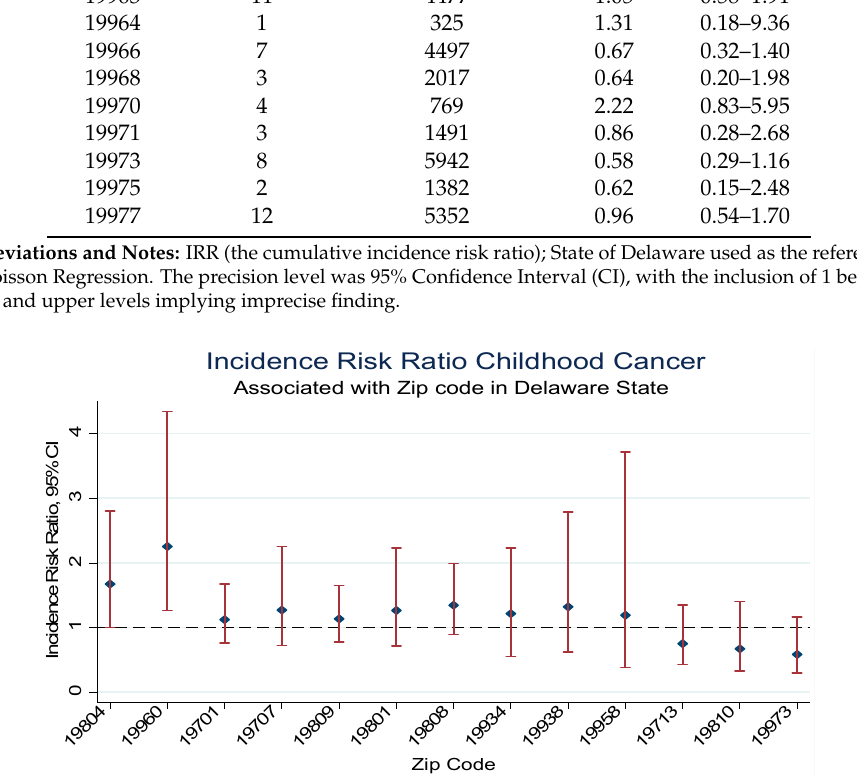
Figure 2. Pediatric Cancer Incidence Risk Ratio Associated with Selective Delaware Zip Codes, 2004–2014.